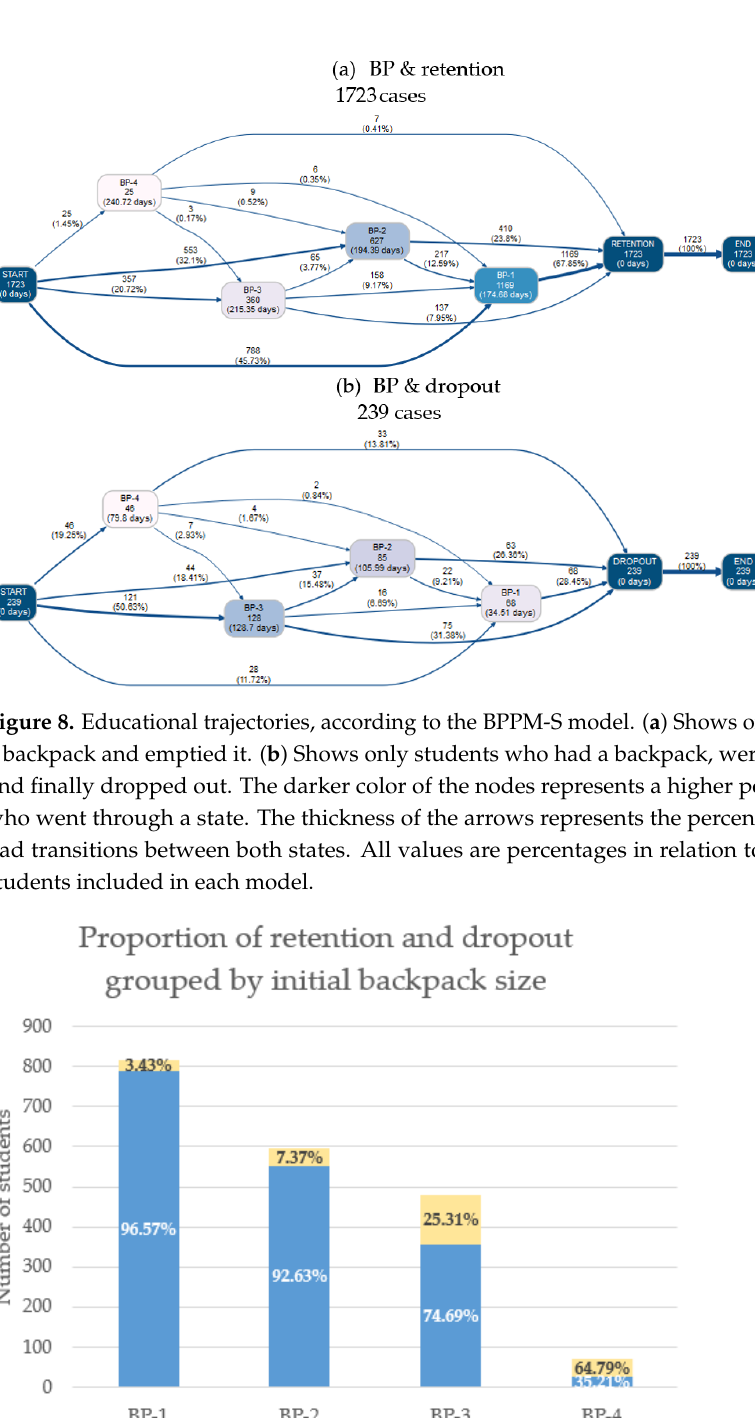
Figure 9. Number and proportion of students who, according to the BPPM-S model, either finished in RETENTION or in DROPOUT, grouped according to the initial backpack size.